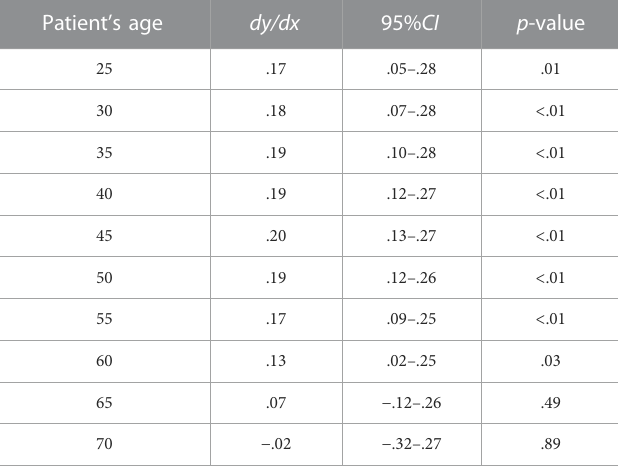
TABLE 5 Fixing patient ’ s age, the marginal effects of chief physician compared with the deputy chief physician on biosimilar uptake.